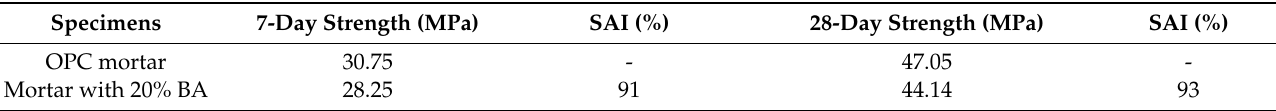
Figure 9. Determination of strength activity index (SAI). Table 5. Strength activity index (SAI) of bagasse ash (BA) *.